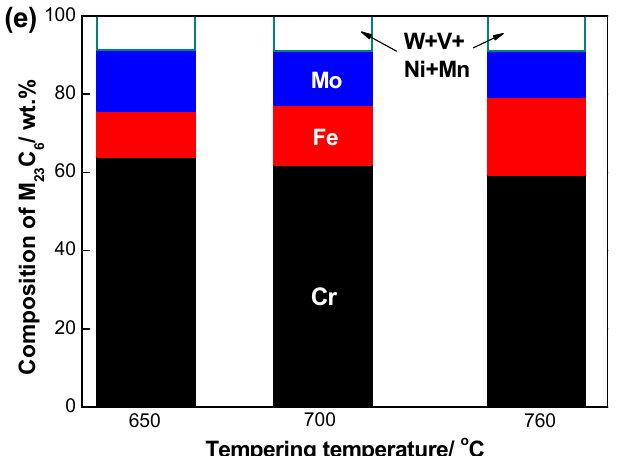
Figure 6. TEM micrographs of 15Cr12MoVWN steel normalized at 1000 °C and tempered at 650 °C. ( a ) M 23 C 6 at grain boundary, ( b ) MX in lath, ( c ) selected area electron diffraction (SAED) of M 23 C 6 in ( a ), ( d ) SAED of MX in ( b ), ( e ) composition of metal cluster, M, in M 23 C 6.